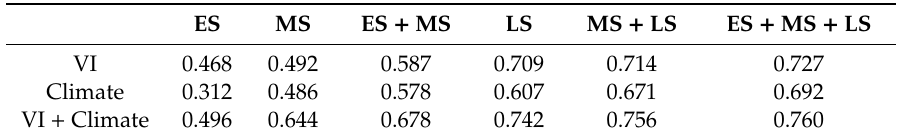
Figure A2. P-values for di ff erent data sources: ( a ) VIs; ( b ) Temperature-related factors; ( c ) Water-related factors; ( d ) Soil properties. Table A1. Model performance comparison using di ff erent sub-season combinations (“ES”: early season; “MS”: middle season; “LS”: late season).